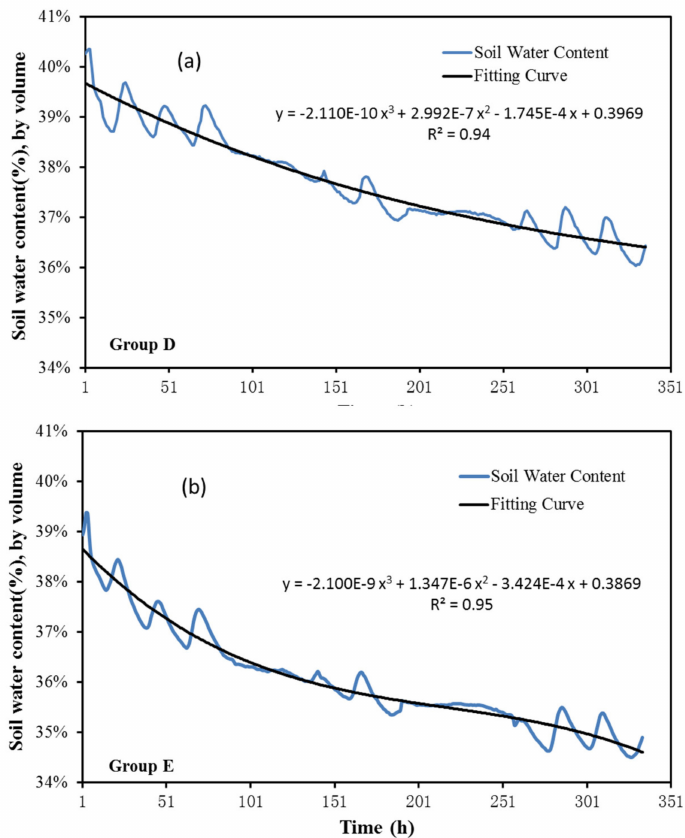
Figure 6. Average dehydration time for composite soil layer of ( a ) Group D on 16 December 2016; ( b ) Group E on 16 December